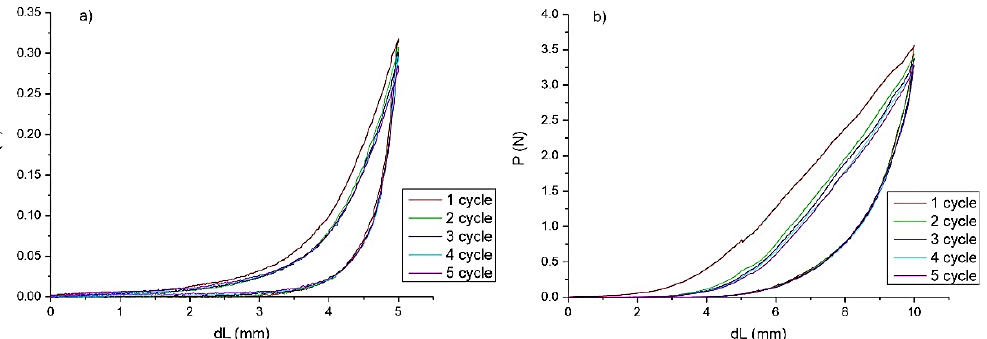
Figure 8. Cyclic tension of knitted TiNi mesh made of a 60 µm diameter wire by 10% ( a ) and 20% ( b ), 5 cycles.